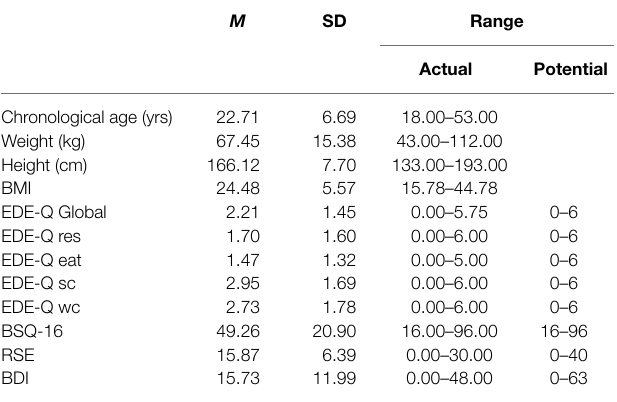
TABLE 1 | Characteristics of